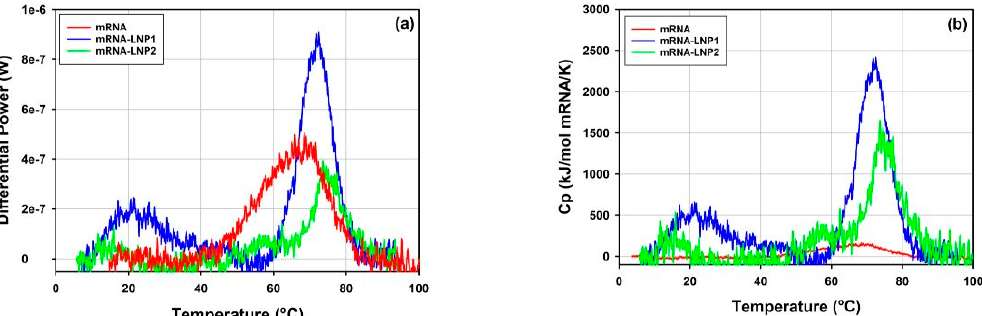
Figure 15. Overlays of the DSC traces of mRNA-LNP1, mRNA-LNP2 and free mRNA samples corrected for the instrumental blank and baseline and presented as ( a ) not normalized differential power and as ( b ) normalized per mole of mRNA for each sample and expressed as apparent excess heat capacity.